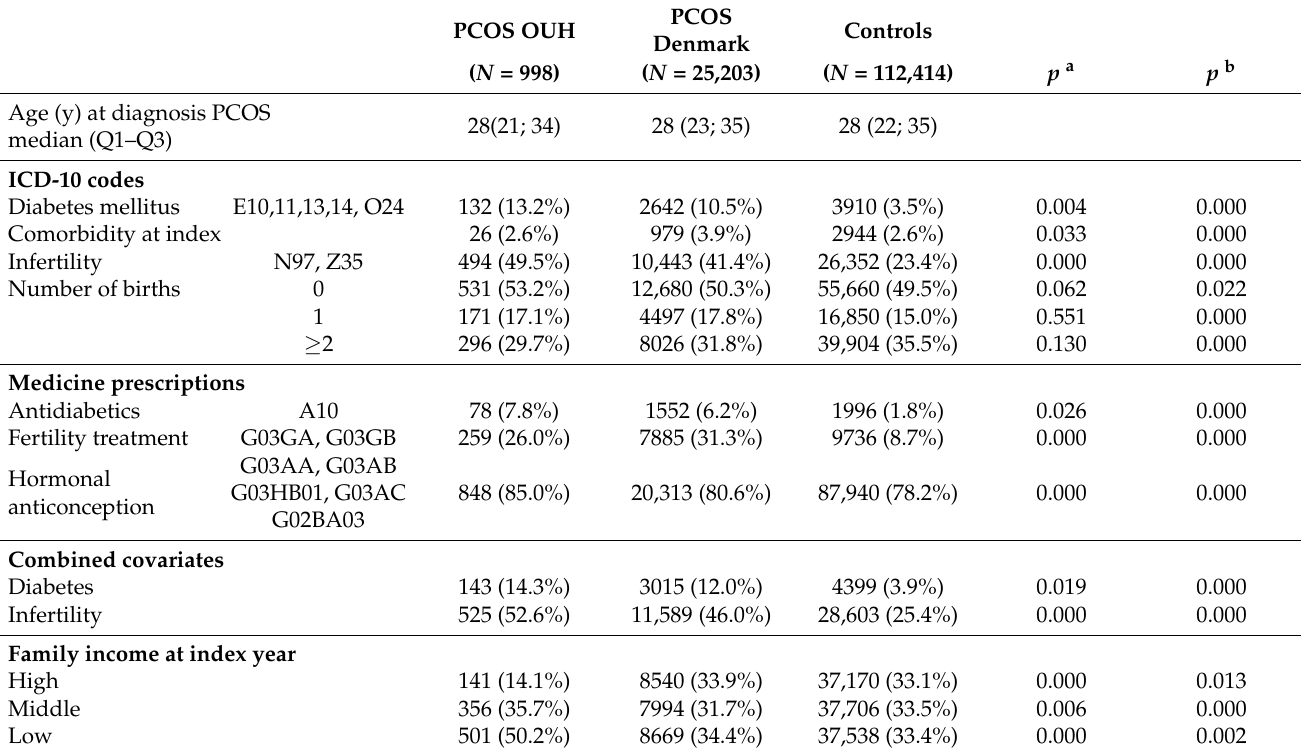
Table 1. Characteristics in women with PCOS and controls until end of follow-up ( N = 136,657). PCOS PCOS OUH Denmark